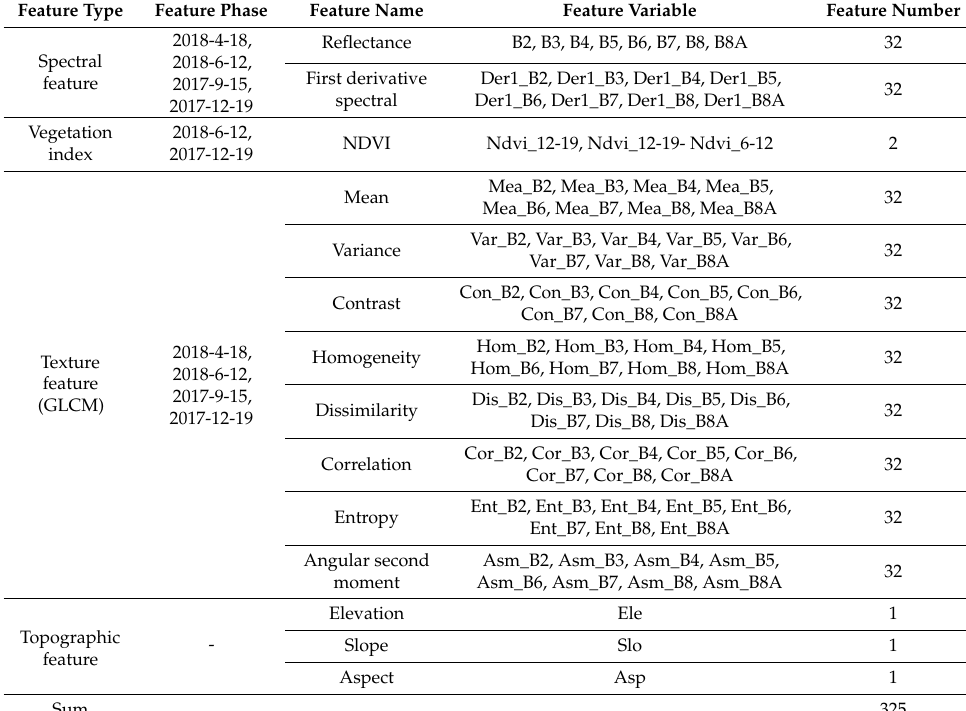
Table 1. Feature parameters extracted from the four Sentinel-2 images and topographic features.